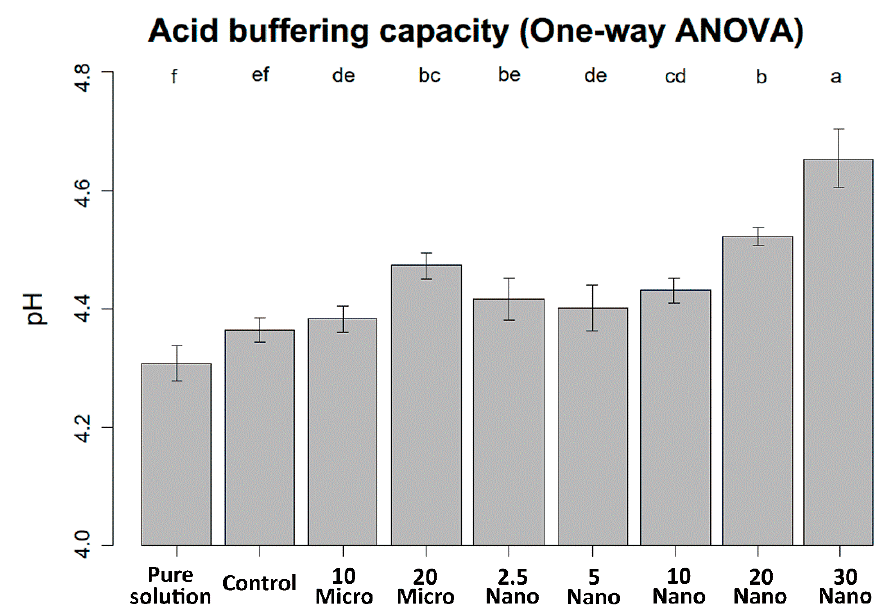
Figure 4. pH levels of the demineralizing solution after immersing the experimental and control specimens for 24 h. Different letters above the bars indicate significant differences.